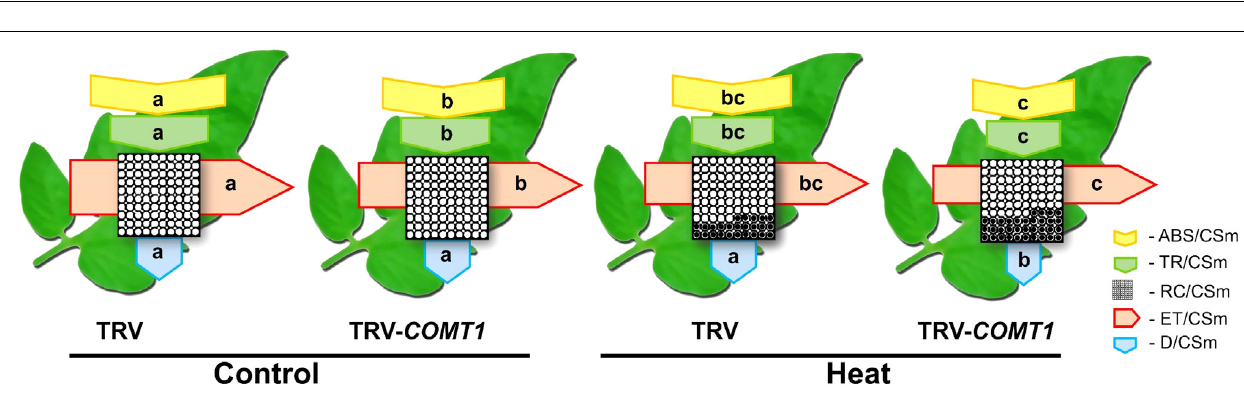
FIGURE 2 | Changes in gas exchange parameters as influenced by COMT1 silencing and heat stress in tomato leaves. (A) The light-saturated rate of CO 2 assimilation ( A sat ), (B) stomatal conductance ( G s ), (C) intercellular CO 2 concentration ( C i ), and (D) transpiration rate ( T r ). Tomato seedlings at five-leaf stage were exposed to 40 ◦ C temperature for 9 h before analysis of gas exchange parameters. Data are presented as the mean of six replicates ( ± SE). Different letters indicate significant differences ( P < 0.05) according to the Tukey’s test.